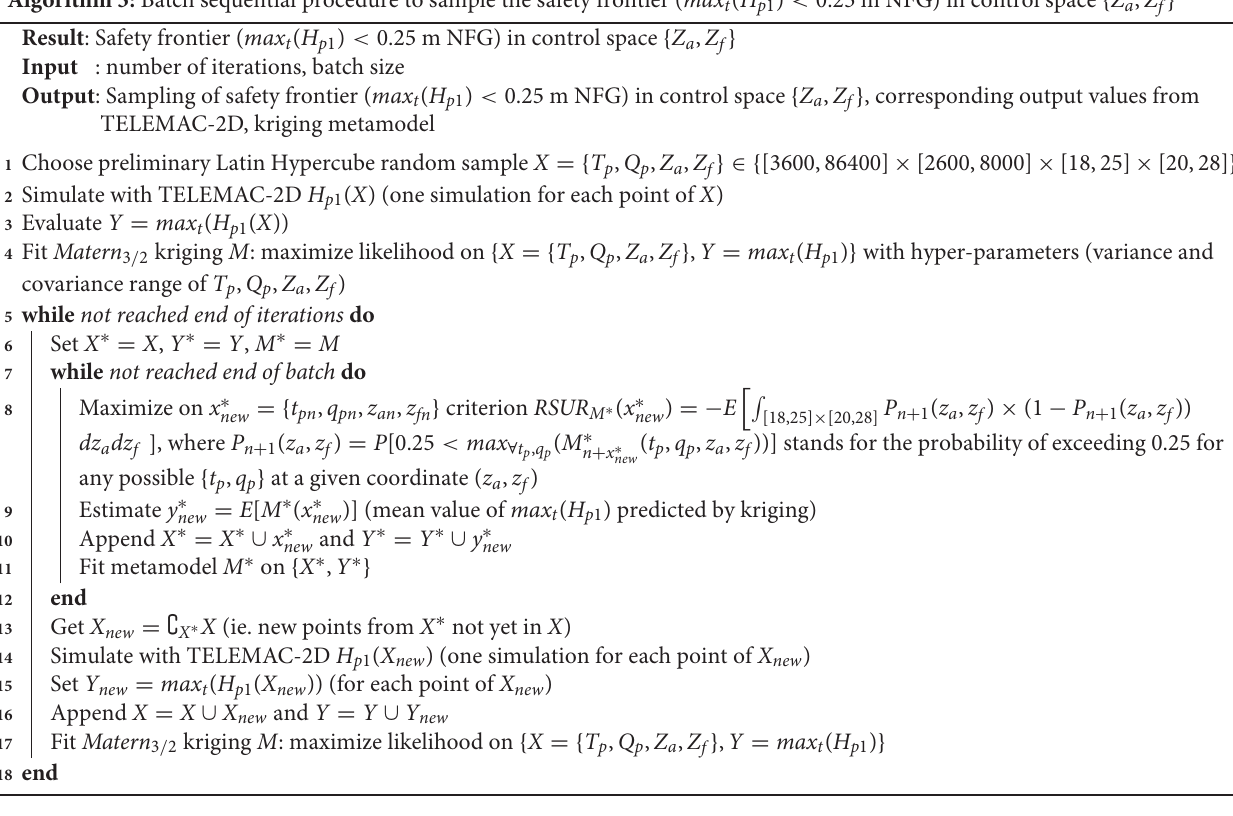
Algorithm 3: Batch sequential procedure to sample the safety frontier ( max t ( H p 1 ) < 0.25 m NFG) in control space { Z a , Z f